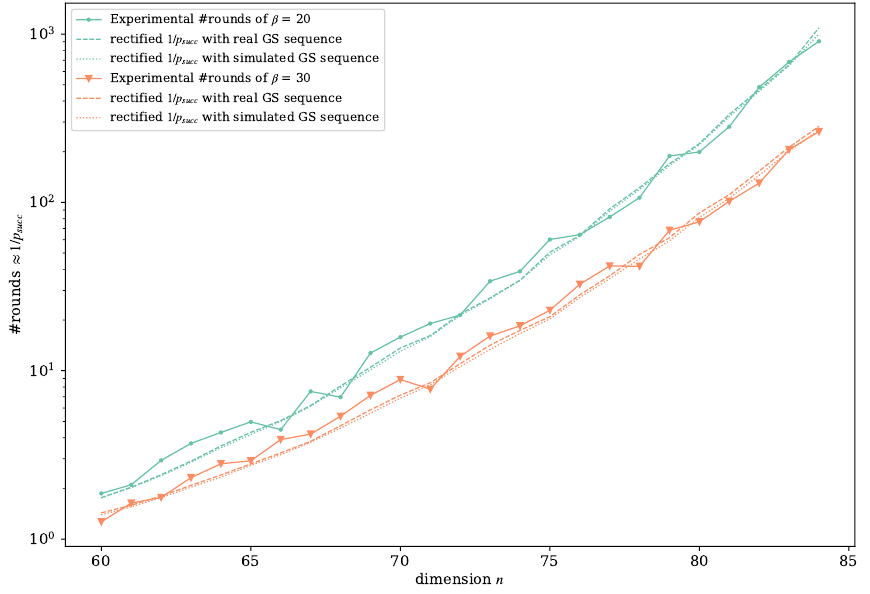
Figure 9. Verification of the rectified success probability